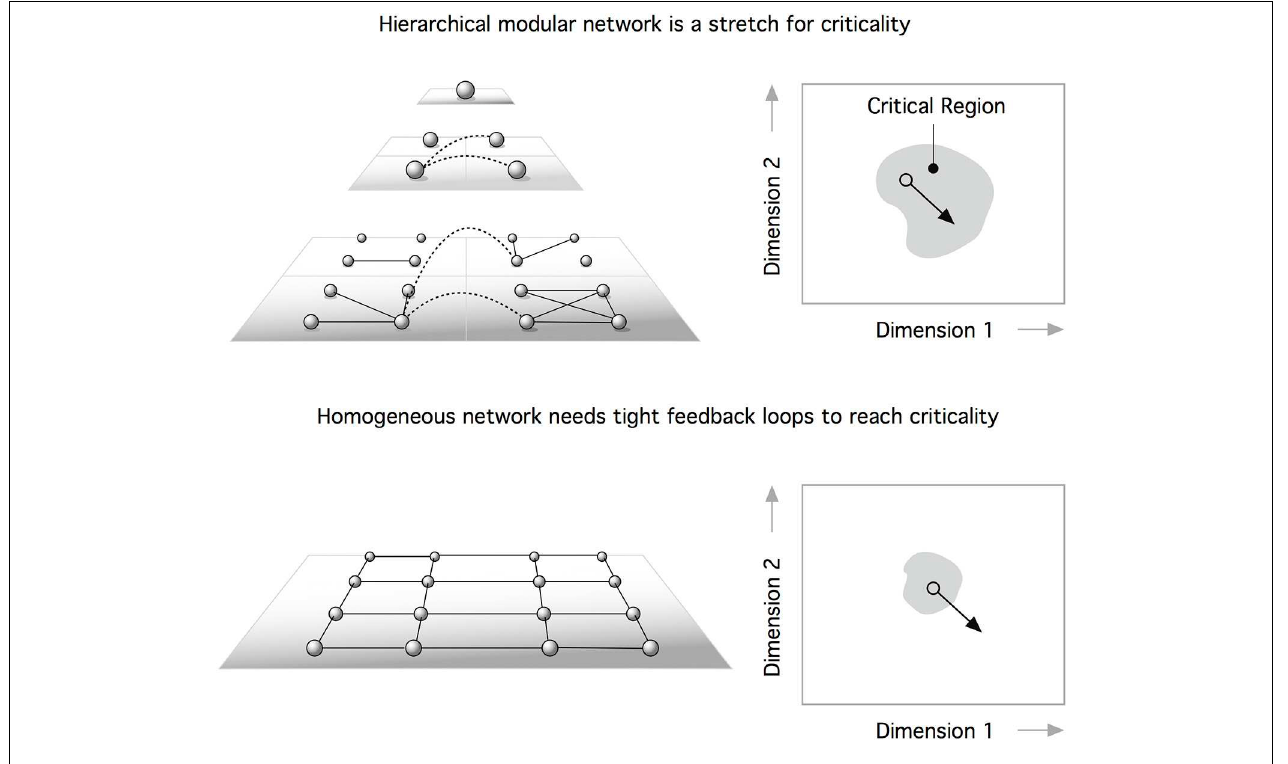
FIGURE 2 | The existence of feedback loops can self-organize neural networks at the critical point. One problem is that perturbations can displace the system outside the critical domain (bottom) . According to Moretti and Muñoz (2013), a hierarchical modular network is a path to